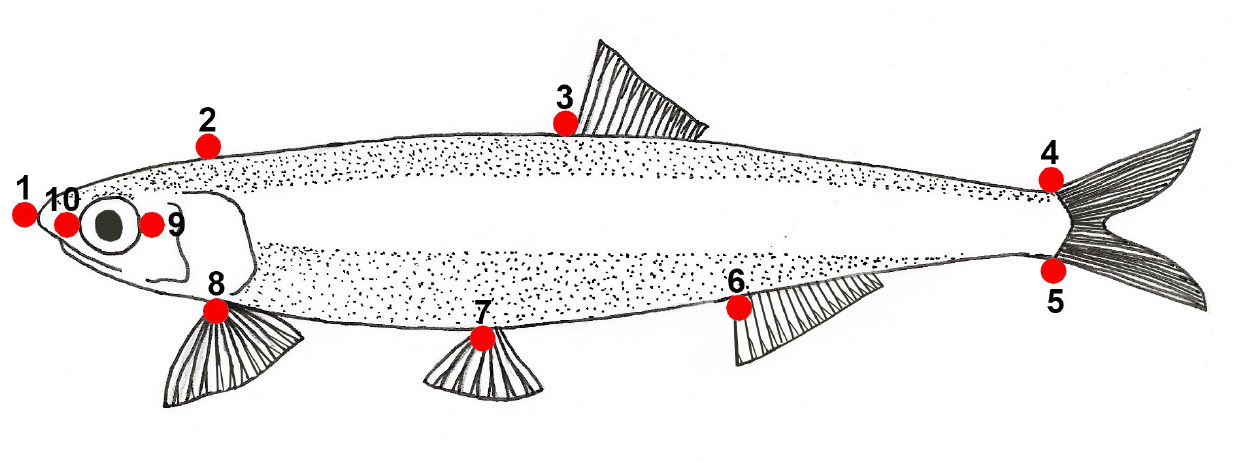
FIGURE 2 | Location of anatomical landmarks used for morphometric analyses: 1- distal point of the rostrum; 2- posterior end of the head; 3-anterior insertion of the dorsal fin; 4- insertion of the first upper radius of caudal fin; 5-insertion of the first lower radius of caudal fin; 6-anterior anal fin insertion; 7- insertion of the ventral fin; 8-insertion of the pectoral fin; 9- posterior end of the eye; 10- anterior end of the